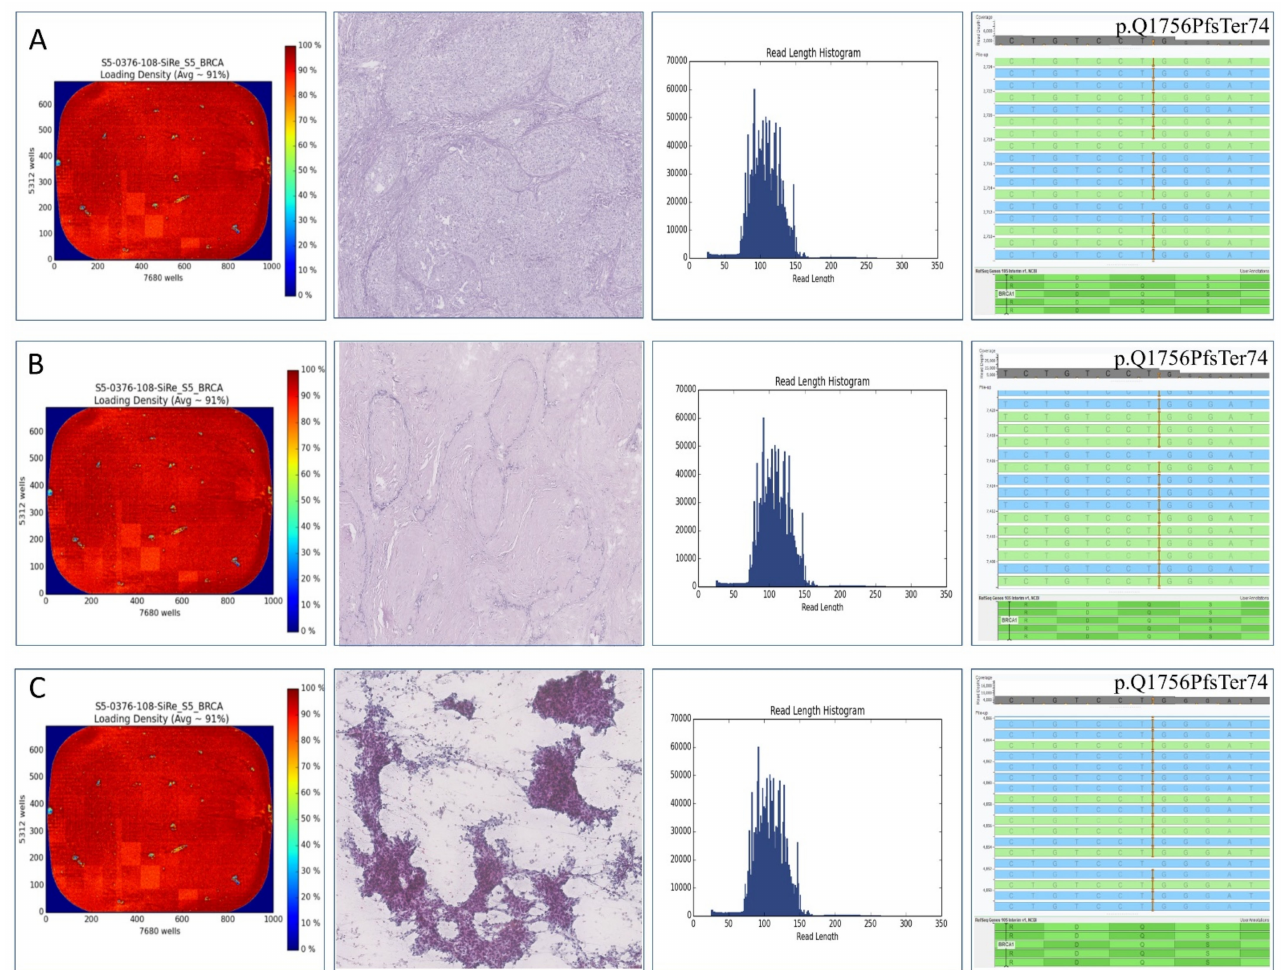
Figure 1. From left to right, Ion Sphere Particles (ISPs) density, morphological features, mean read length and visual inspection of generated reads for the surgical resection ( A ), fibroadenoma ( B ) and cytological smear ( C